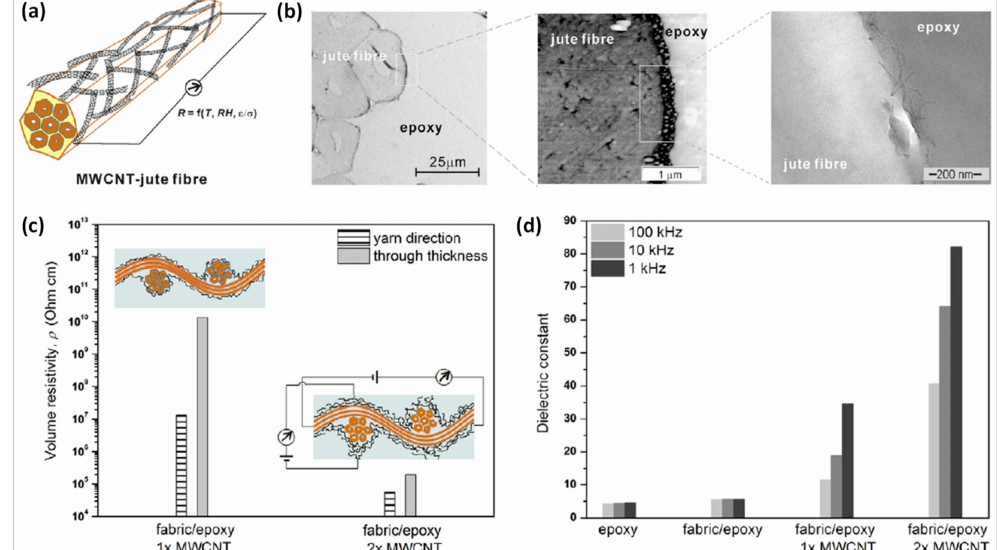
Figure 13. ( a ) Schematic presentation of single multi-walled CNT modified jute fibre, ( b ) from left to right are the SEM, EFM phase, and TEM images of the cross-section of the MWCNT-jute fibre/epoxy biocomposite, ( c ) comparison of the volume electrical resistivity of jute fabric/epoxy composites along yarn and through thickness directions, and ( d ) dependence of dielectric constant of jute fabric/epoxy composites on the measurement frequency and fabric treatment conditions (reprinted with permission from Zhuang et al., 2011